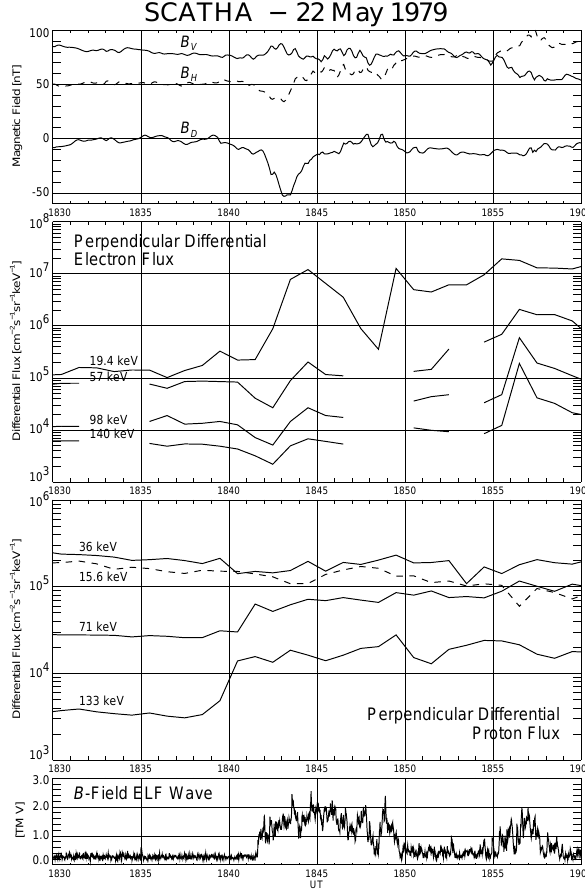
Fig. 3. GEOS-2 measurements as functions of time. From top to bottom: 1. Three magnetic field components; 2. Differential high energy electron flux intensity; 3. Differential high energy ion flux intensity; 4. Integrated power of magnetic field oscillations in fre- quency range 0.5–11Hz.